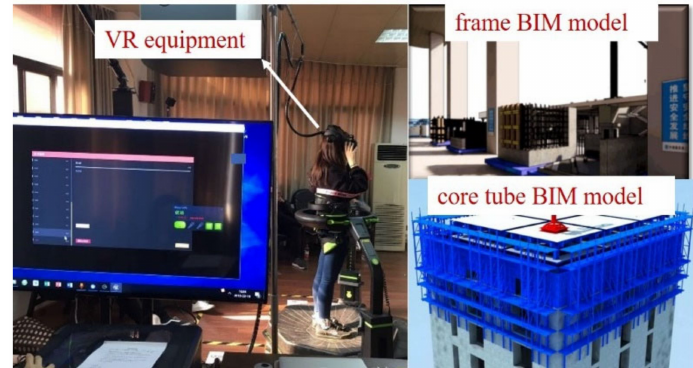
Figure 4. Evacuation speed test with VR equipment and BIM